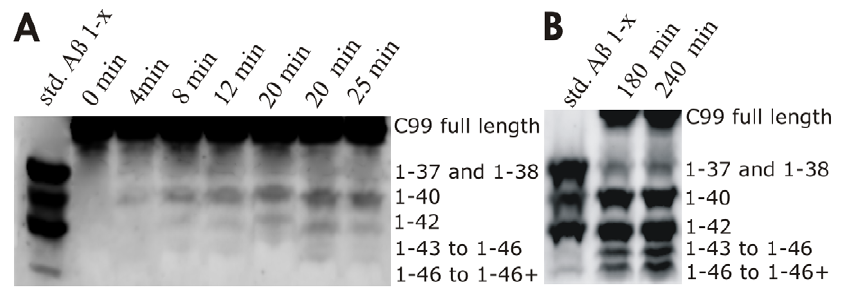
Figure 2. Urea gels show A b 1-x products in different phases of c -secretase reaction. The reactions were prepared using CHAPSO enriched c -secretase membranes (total protein 0.25 mg/ml), and saturating concentration of C99 substrate (3.0 m M). The lanes ‘‘A b std 1-x’’ represents synthetic peptides as mobility standards. To facilitate detection of the early data points ( A ) the reaction volume was twenty fold bigger than usual, and the resulting 1-x A b products were concentrated about twenty-fold by immunoprecipitation using protein G beads and polyclonal antibodies specific for the first 5 amino acids. It is necessary to mention that pre-incubation of the assay mix for several hours prior to the start of reaction (i.e. addition of C99 substrate) does not affect the relative distribution of different A b products. Therefore, the observed changes are not due to enzyme denaturation during the course of the reaction.